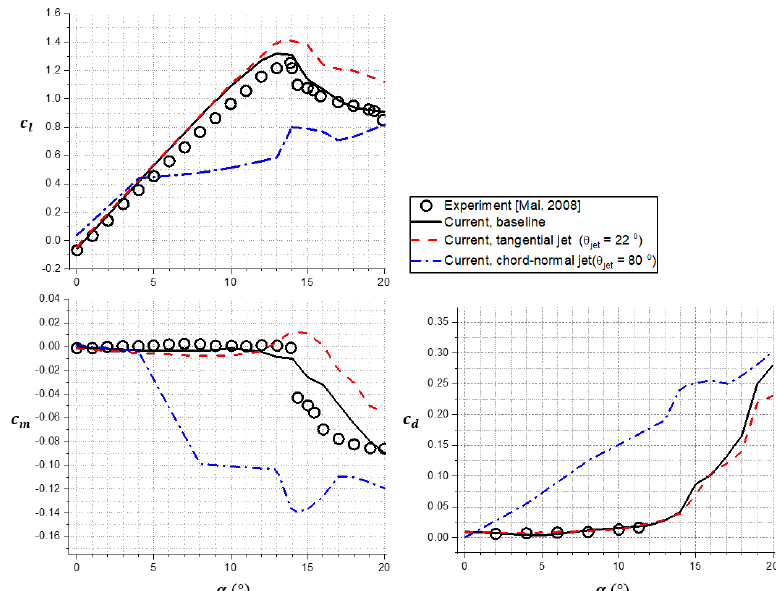
Figure 7. Static OA209 airfoil with and without steady-blowing jets. Ma = 0.3, Re = 1.15 M, c µ = 0.06.